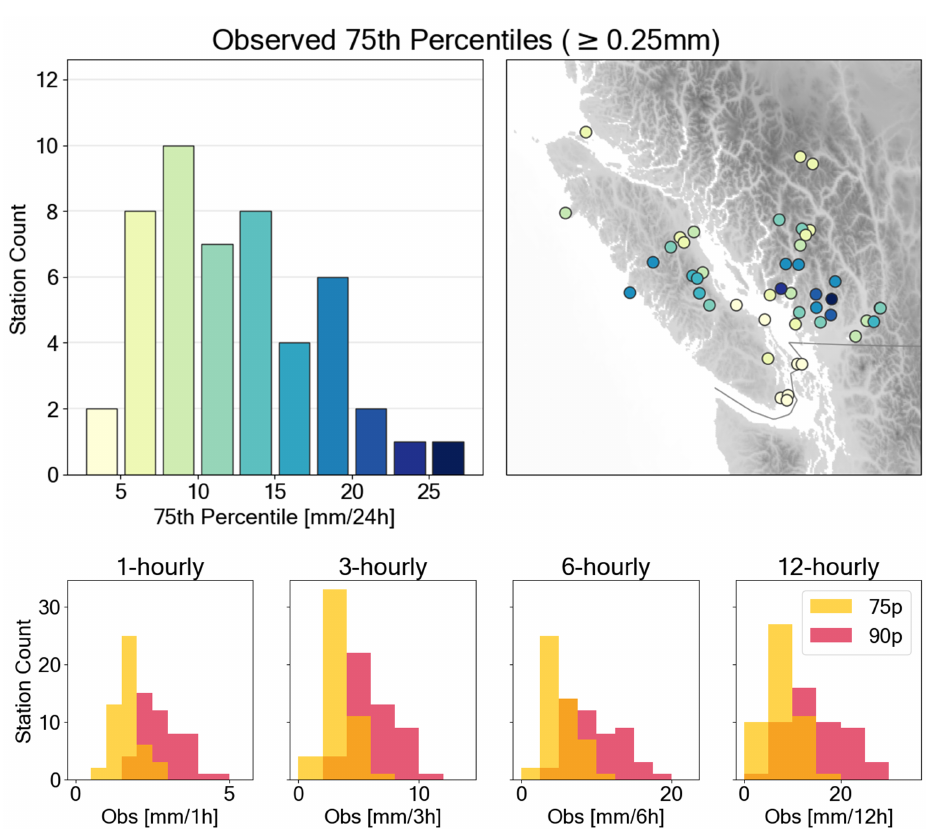
Figure A1. Top row: Histogram of binned daily observed 75th percentiles (75p) at all stations (top left), and corresponding geographic distribution of the 75p relative to topography (top right); Bottom row: Histograms of 75p and 90p for other accumulations. Although not plotted here, these frequency distributions show similar geographic variations to the top right